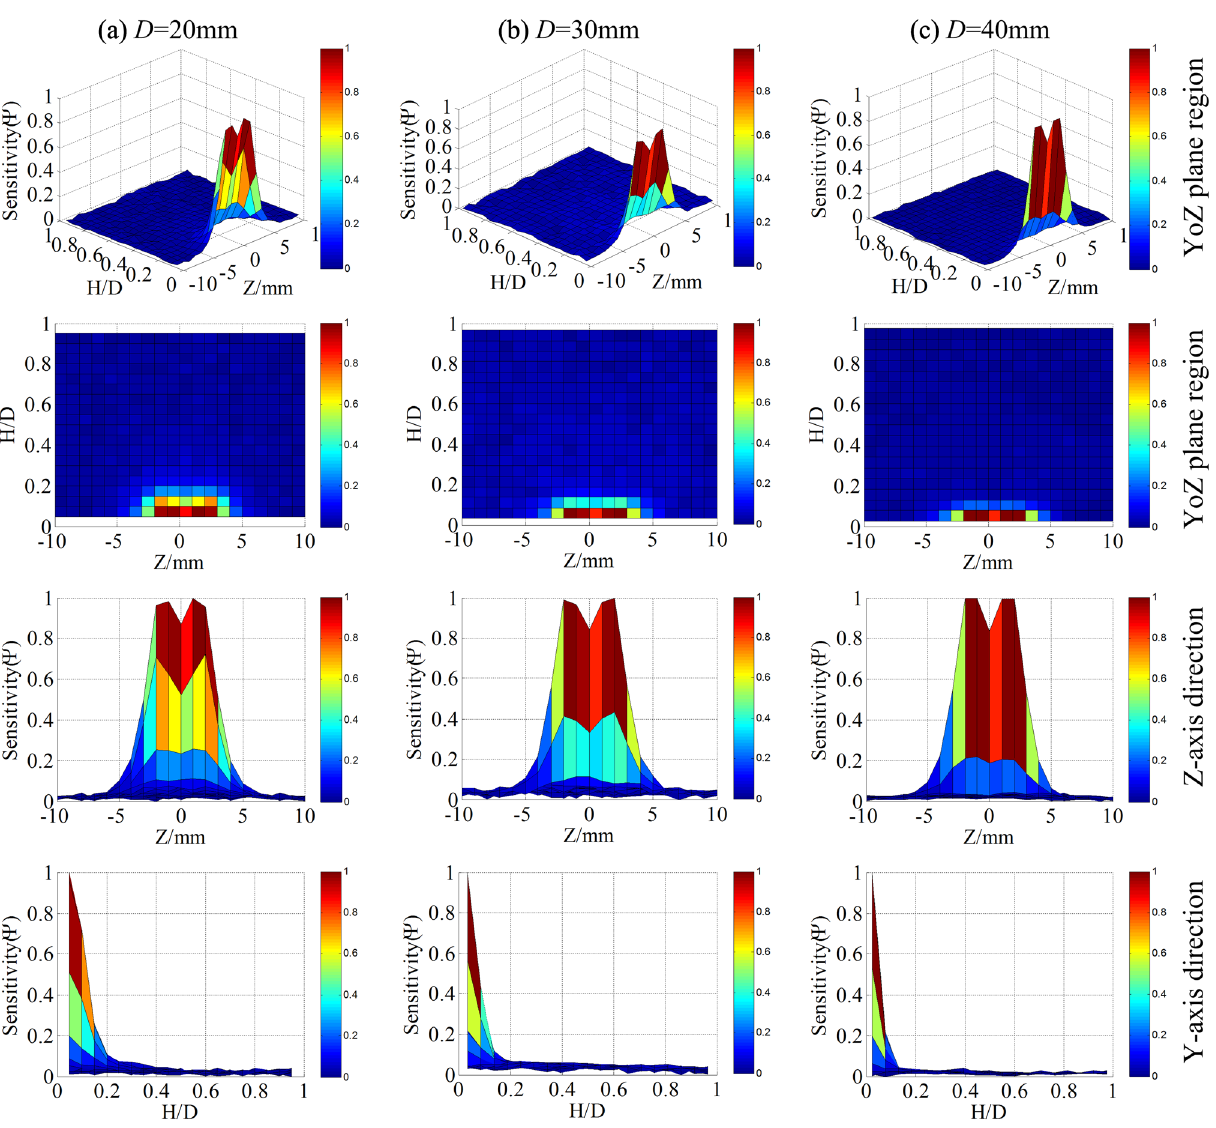
Fig. 7 Distribution maps of spatial sensitivity of MCP 1 under six different D values: h = 2 mm, d = 1.5 mm and S = 4